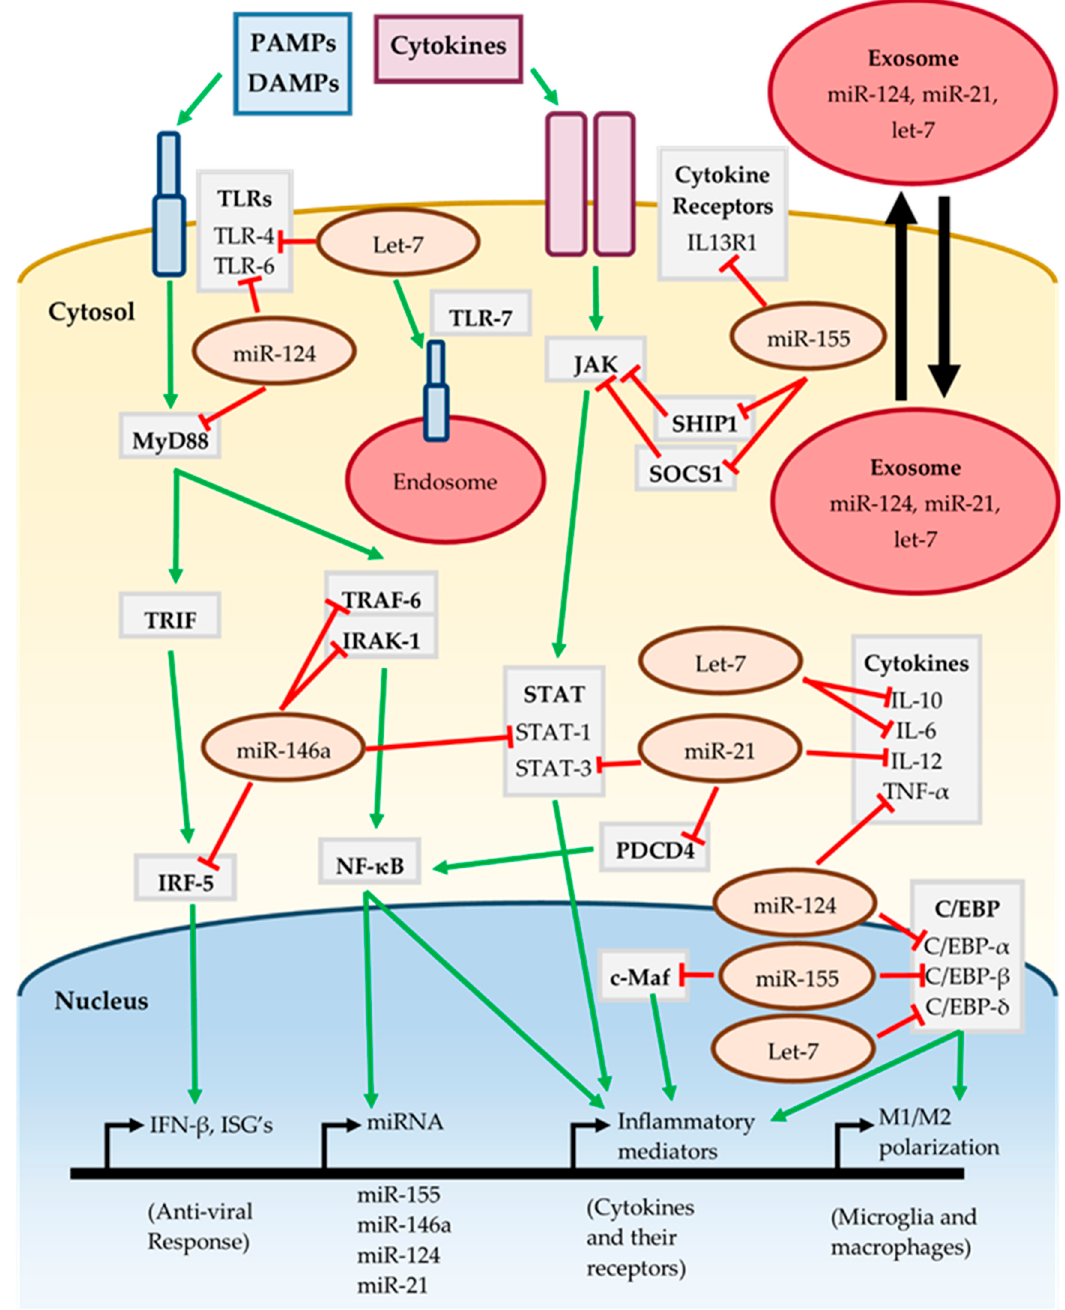
Figure 1. Inflammatory signaling of miRNA. See text for further details and references.